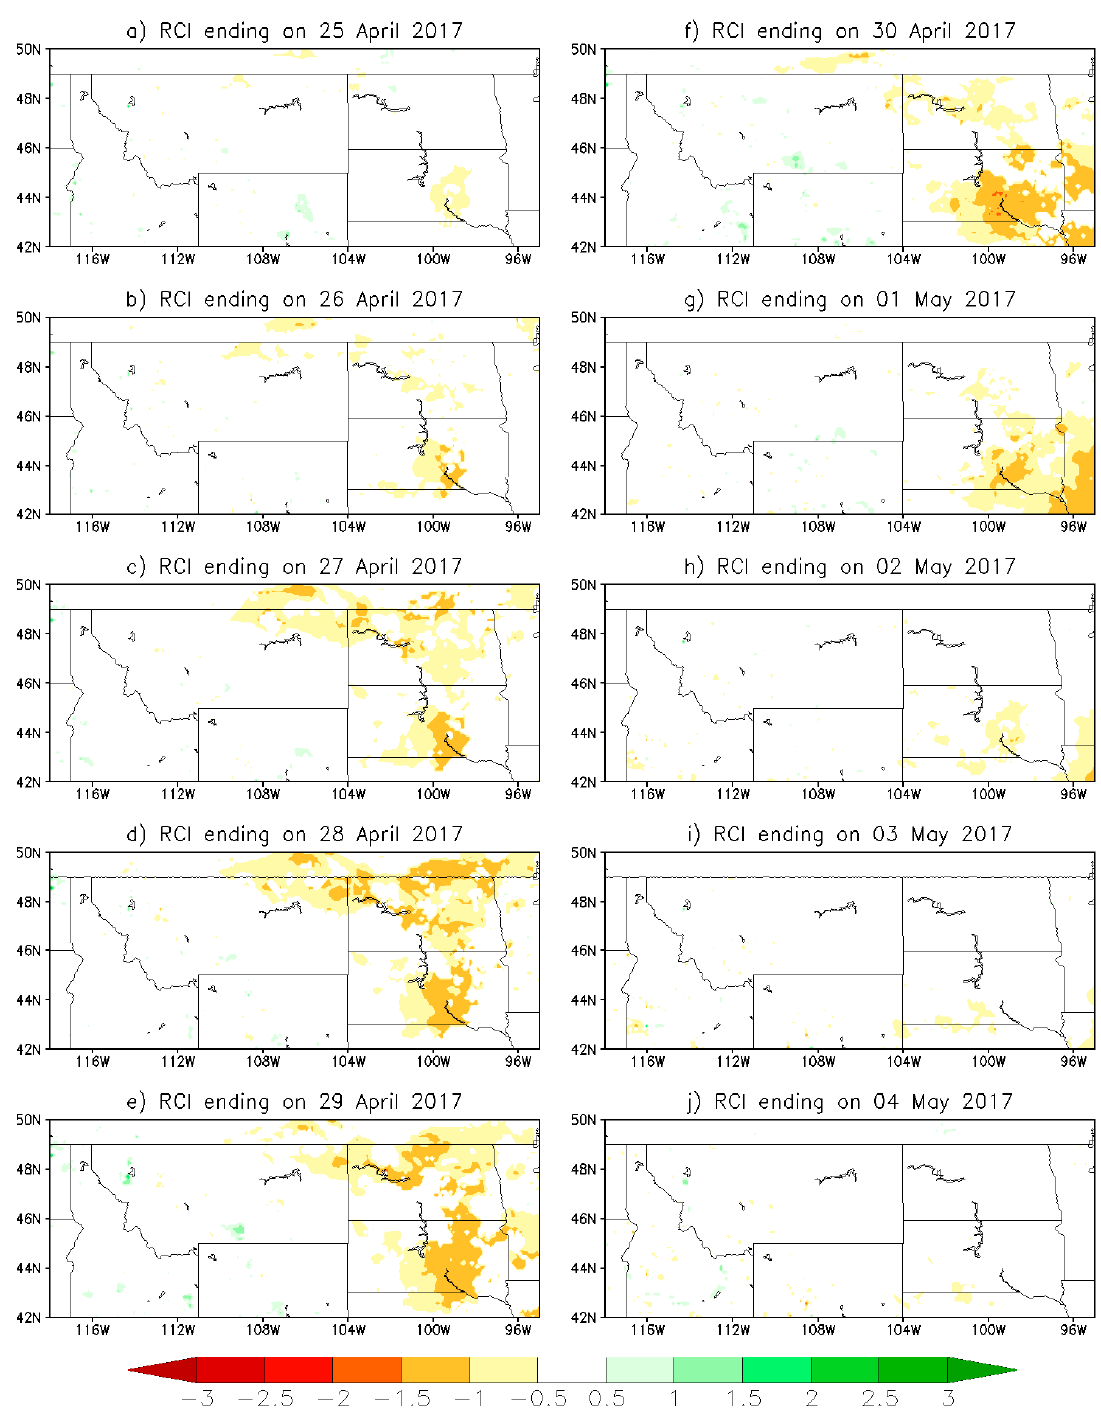
Figure 1. Daily rapid change index (RCI) maps over the Northern High Plains region from 25 April to 4 May 2017 ( a – j ).